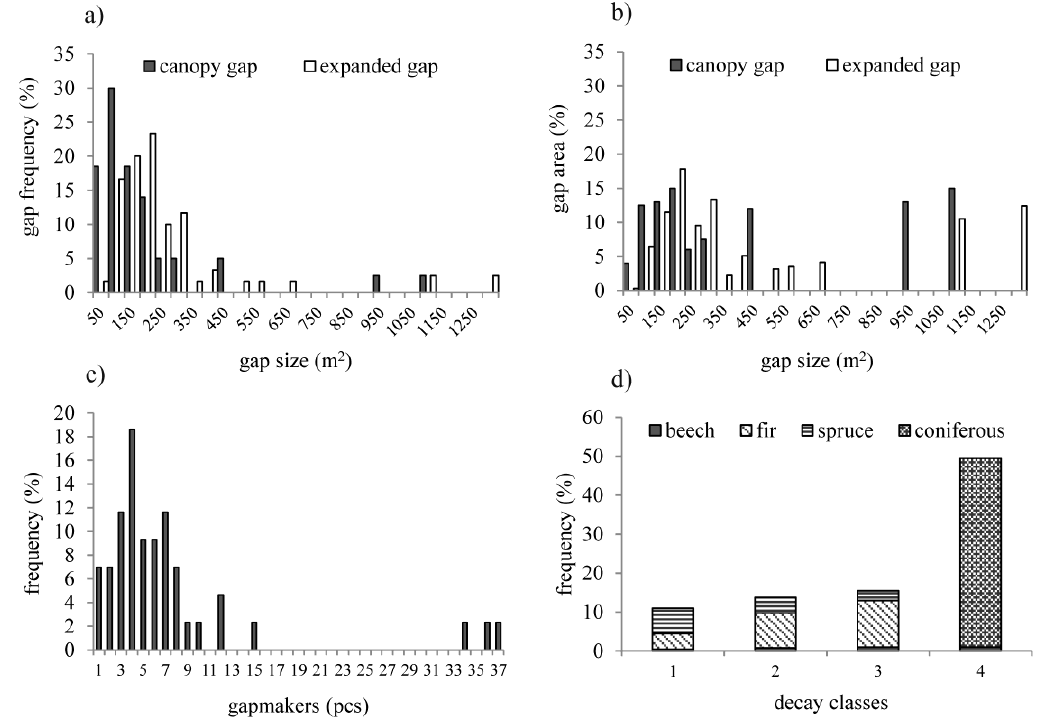
Figure 5. Frequency of canopy and expanded gaps ( a ) and proportion of total gap area ( b ) according to size classes. Gap frequency according to number of gapmakers per gap ( c ). Frequency of gapmakers by decay class and tree species ( d ).